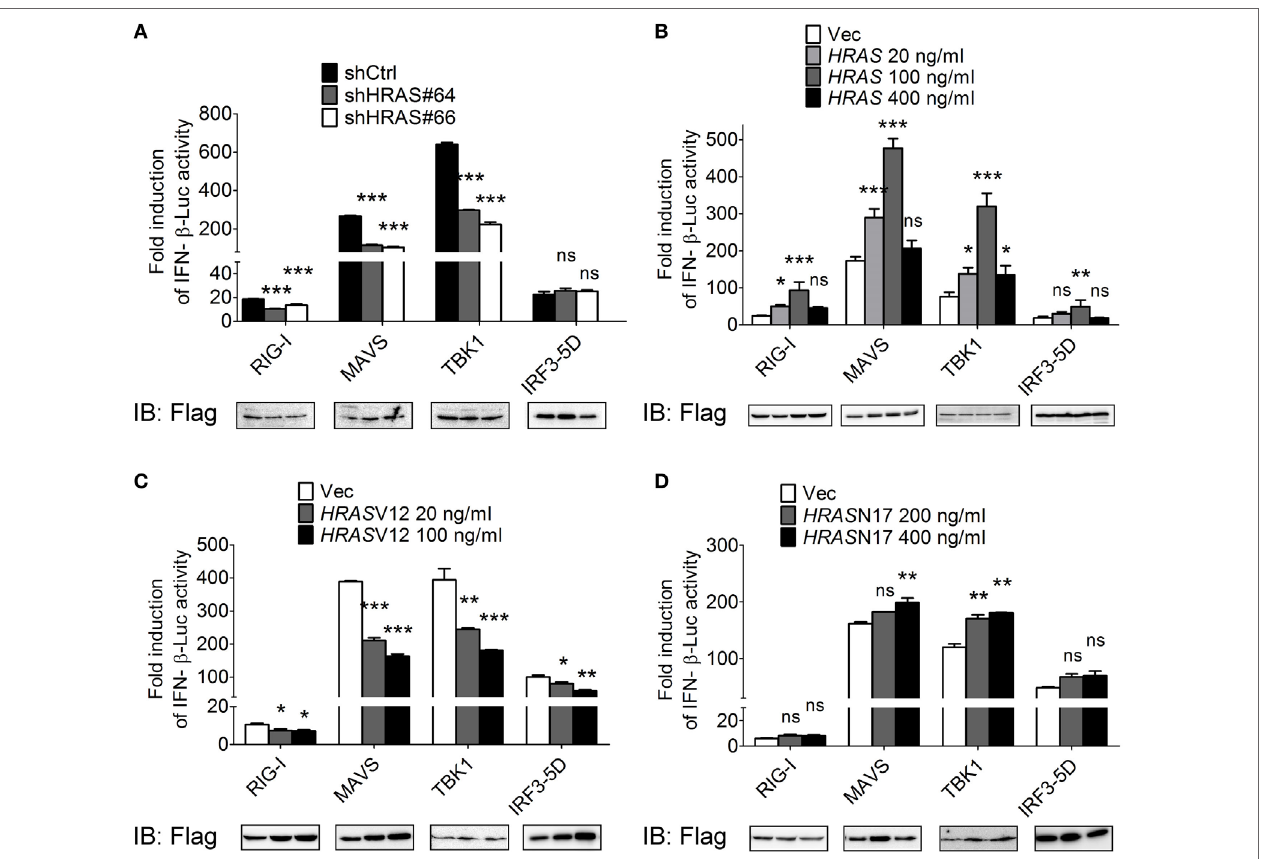
FigUre 4 | H-Ras protein acts on the RLR signaling pathway upstream of IRF3. HEK293T cells were depleted of H-Ras by shHRAS#64 or #66 (a) , or transfected with wild-type HRAS (B) , HRAS V12 (c) , or HRAS N17 (D) at the indicated doses. The cells were also transfected with the pIFN- β -Luc reporter plasmid and the pTK-RL reporter plasmid together with the Flag-tagged retinoic acid-inducible gene-I (RIG-I)-, MAVS-, TBK1-, or IRF3-5D-expressing plasmids to induce the RLR signaling. In all groups, the total amounts of transfected DNA were adjusted to the same using the control vector DNA. Luciferase activities were measured at 24 h post-transfection. The expression levels of each transfected inducer molecule were revealed by Western blot shown below the bar chart. The results of induction fold were obtained from three independent experiments and presented as the mean ± SD. * P < 0.05, ** P < 0.01, and *** P < 0.001 between the indicated groups and the shCtrl-treated or the vector-transfected group (one-way ANOVA followed by Dunnett’s post hoc analysis). ns, not